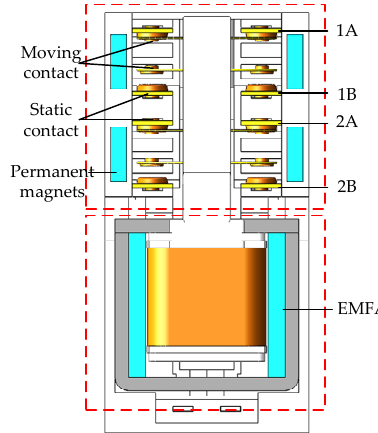
Figure 2. Schematic diagram of the novel contactor structure.